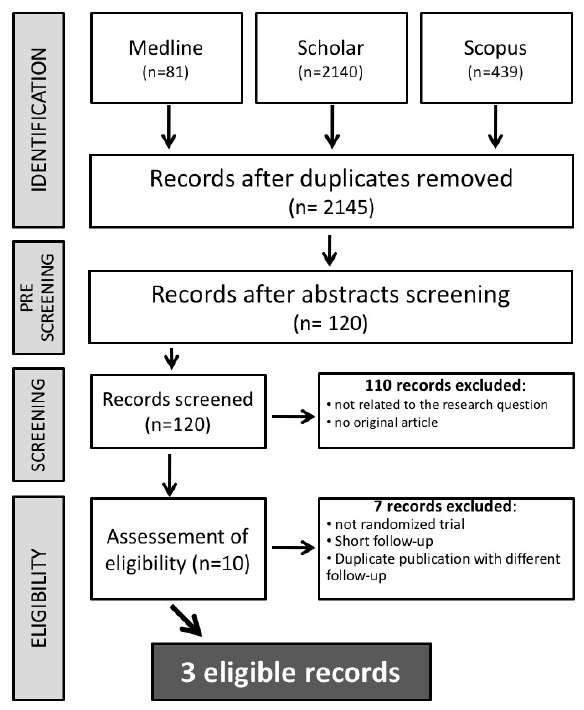
Figure 1. Study selection flow chart.